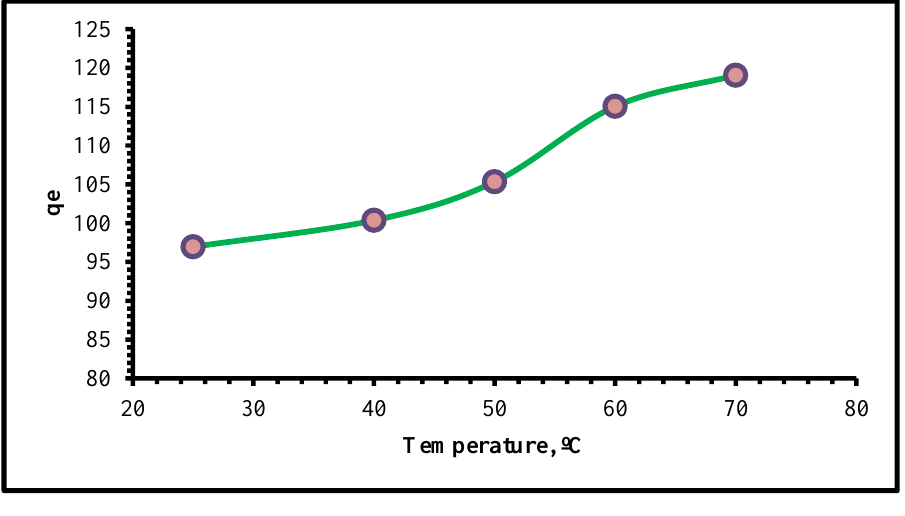
Figure 13. Effect of temperature on the adsorption % of W(VI) using HNAP/QA (pH 4.5, W(VI) = 250 mg L −1 , 20 mL solution, 0.08 g).